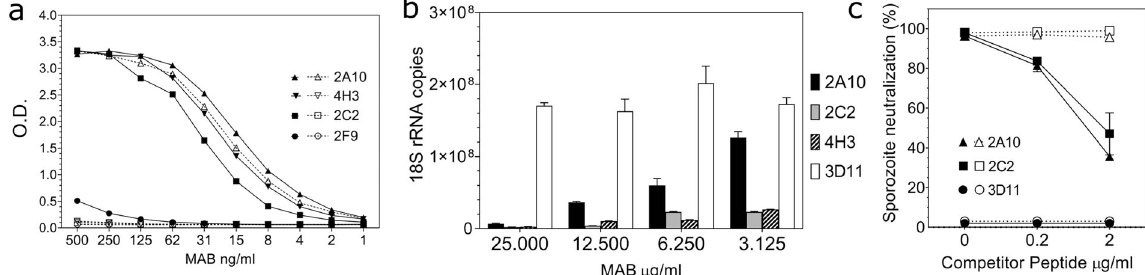
Fig. 2 Fine speci fi city and sporozoite-neutralizing activity of MAB derived from P. falciparum sporozoite-immunized mice. a MAB initially selected by P. falciparum sporozoite IFA were analyzed for fi ne speci fi city using CS repeat peptide ELISA. ELISA plates coated with either minor repeat peptide (DPNANPNV) 2 [closed symbols] or major repeat peptides (NANP) 3 [open symbols] were reacted with two-fold dilutions of MAB. b Sporozoite-neutralizing activity of MAB speci fi c for minor repeats was determined by TSNA using transgenic P. berghei sporozoites expressing P. falciparum CS repeats (PfPb). Sporozoites were incubated with MAB 2C2 and 4H3, speci fi c for P. falciparum CS minor repeats, or MAB 2A10 which cross-reacts with both the minor and major repeats. MAB 3D11 speci fi c for P. berghei CS repeats served as negative control. Hepatoma cell extracts of duplicate wells obtained 48 h post sporozoite infection were pooled and tested in triplicate by qRT-PCR and results are shown as mean ± SD 18 S rRNA copy number. At all concentrations tested, the minor repeat-speci fi c MABs 2C2 and 4H3, and MAB 2A10, minor repeat peptide (DPNANPNV) 2 [closed symbols] or major repeat peptide (NANP) 3 [open symbols]. MAB 3D11 served as negative control. Following incubation of MABs with competitor peptide for 1 h at 37 °C, PfPb sporozoites were added and TSNA was carried out per protocol using qRT-PCR. Results are shown as percent inhibition ± competitor peptide. For MAB 2A10 and MAB 2C2 there was a signi fi cant difference in rRNA copy number in presence of 2 µg/ml and 0.2 µg competitor minor repeat peptide versus no peptide (one-way ANOVA with Dunnett ’ s test, adjusted P <